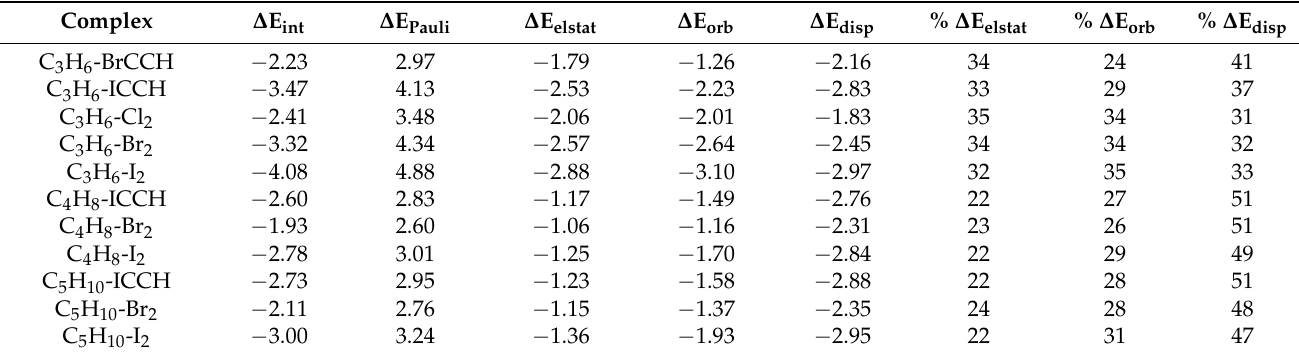
Table 4. The total interaction energy and its terms (see Section 3, Computational Approaches) for selected complexes analysed in this study, all expressed in kcal/mol. The percentage contributions of the attractive terms are given (in relation to the sum of all attractive interaction energy